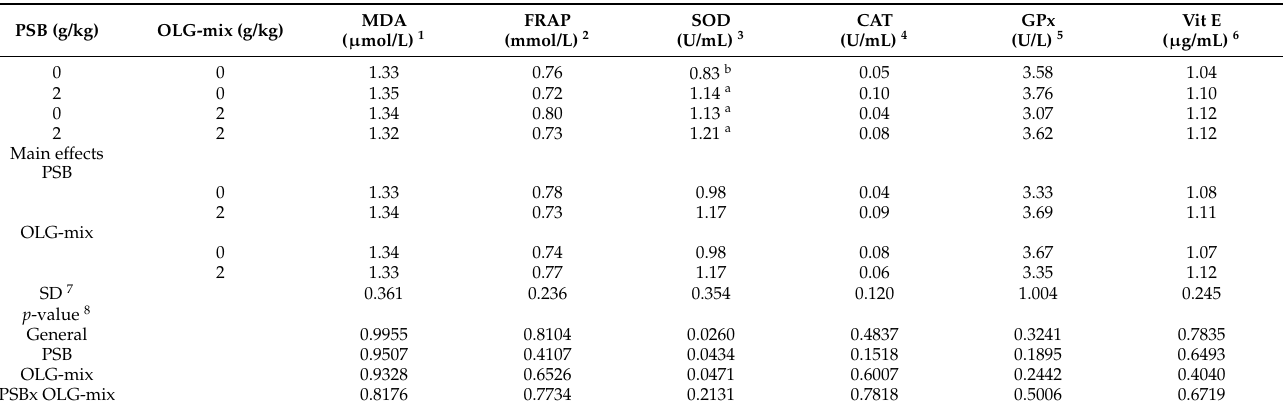
Table 5. Effects of protected sodium butyrate (PSB) and olive leaf and grape-based by-product (OLG-mix), and their interaction on different blood antioxidant parameters (40 days of